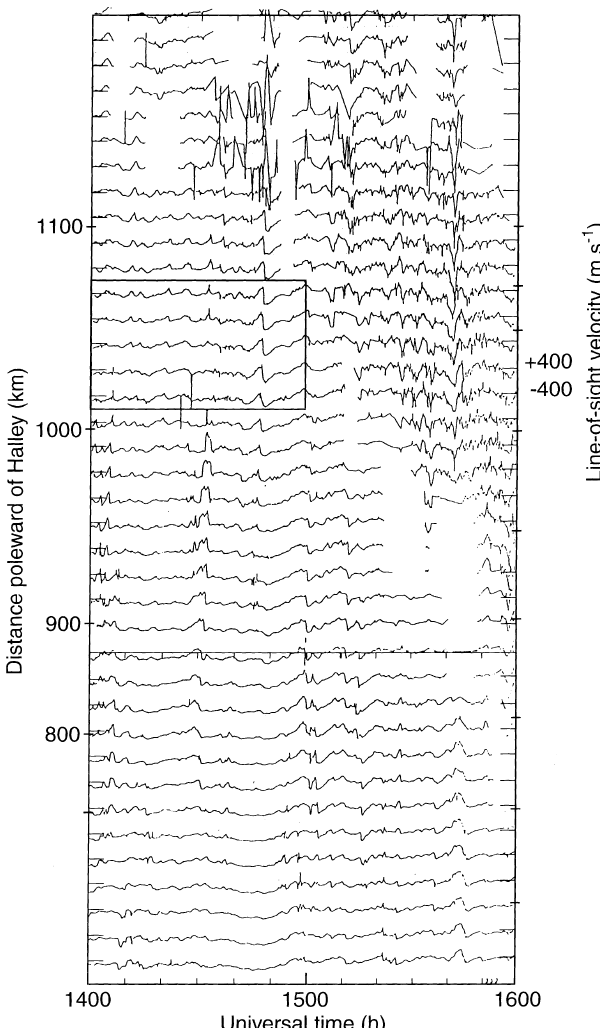
Fig. 2. The line-of-sight velocity determined at 15 km range intervals from 700–1200 km poleward of Halley for the period 1400–1600 UT on 5 February 1994. The region of highly variable line-of-sight velocity which moves progressively equatorward is where cusp precipitation is occurring. This is especially clear above (cid:24) 1000 km range after 1500 UT. The data in the boxed area are reproduced in Fig. 3 on an